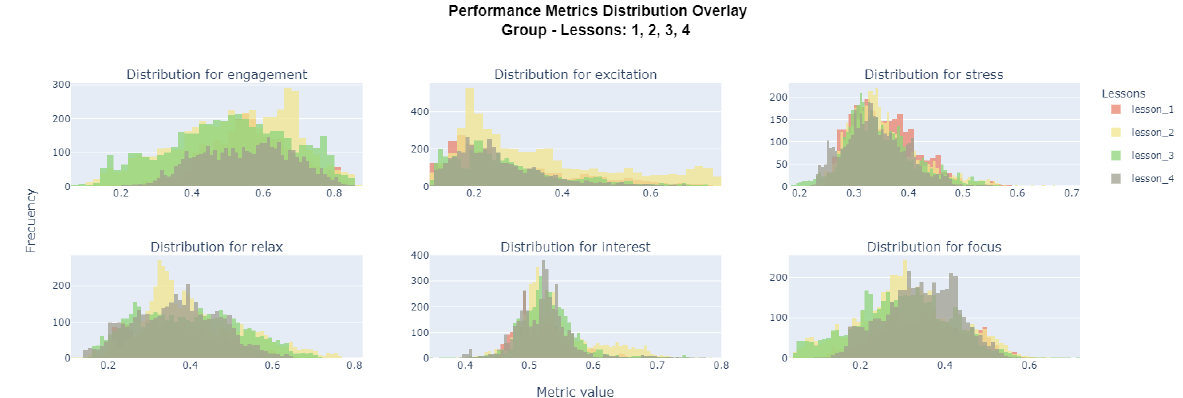
Figure 8. Overlapping distributions of group’s emotional metrics and lessons.